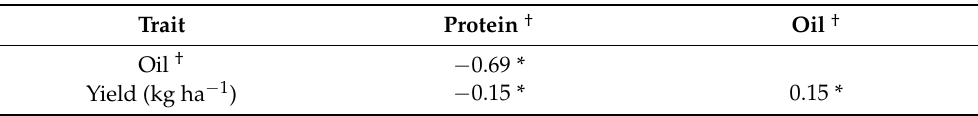
Table 3. Pearson’s correlation coefficient between protein, oil and yield in 302 F 5:11 -derived